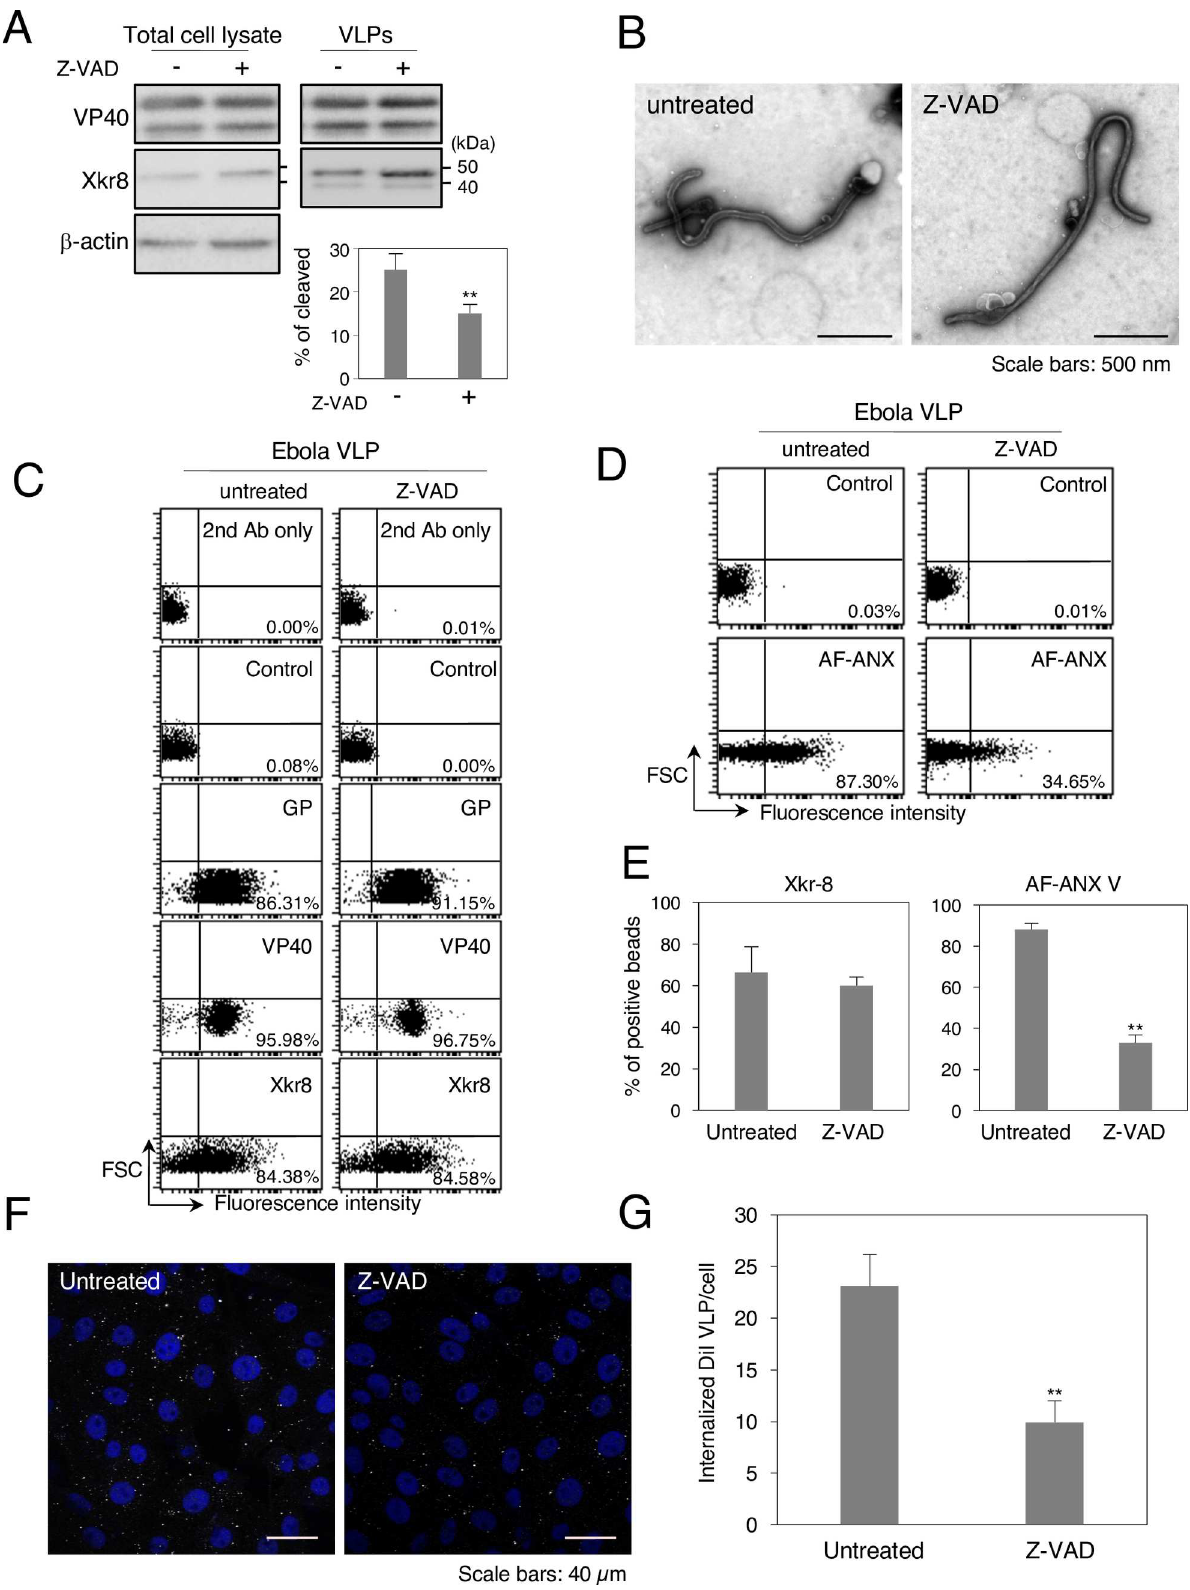
Fig 6. Effect of a pan-caspase inhibitor on the externalization of PS on the surface of Ebola VLPs and their internalization. (A) The effect of a pan-caspase inhibitor on Xkr8 in cell lysate and VLPs. 293T cells were transfected with the expression plasmids of EBOV VP40, GP, and NP and PLOS Pathogens| https://doi.org/10.1371/journal.ppat.1006848 January16,